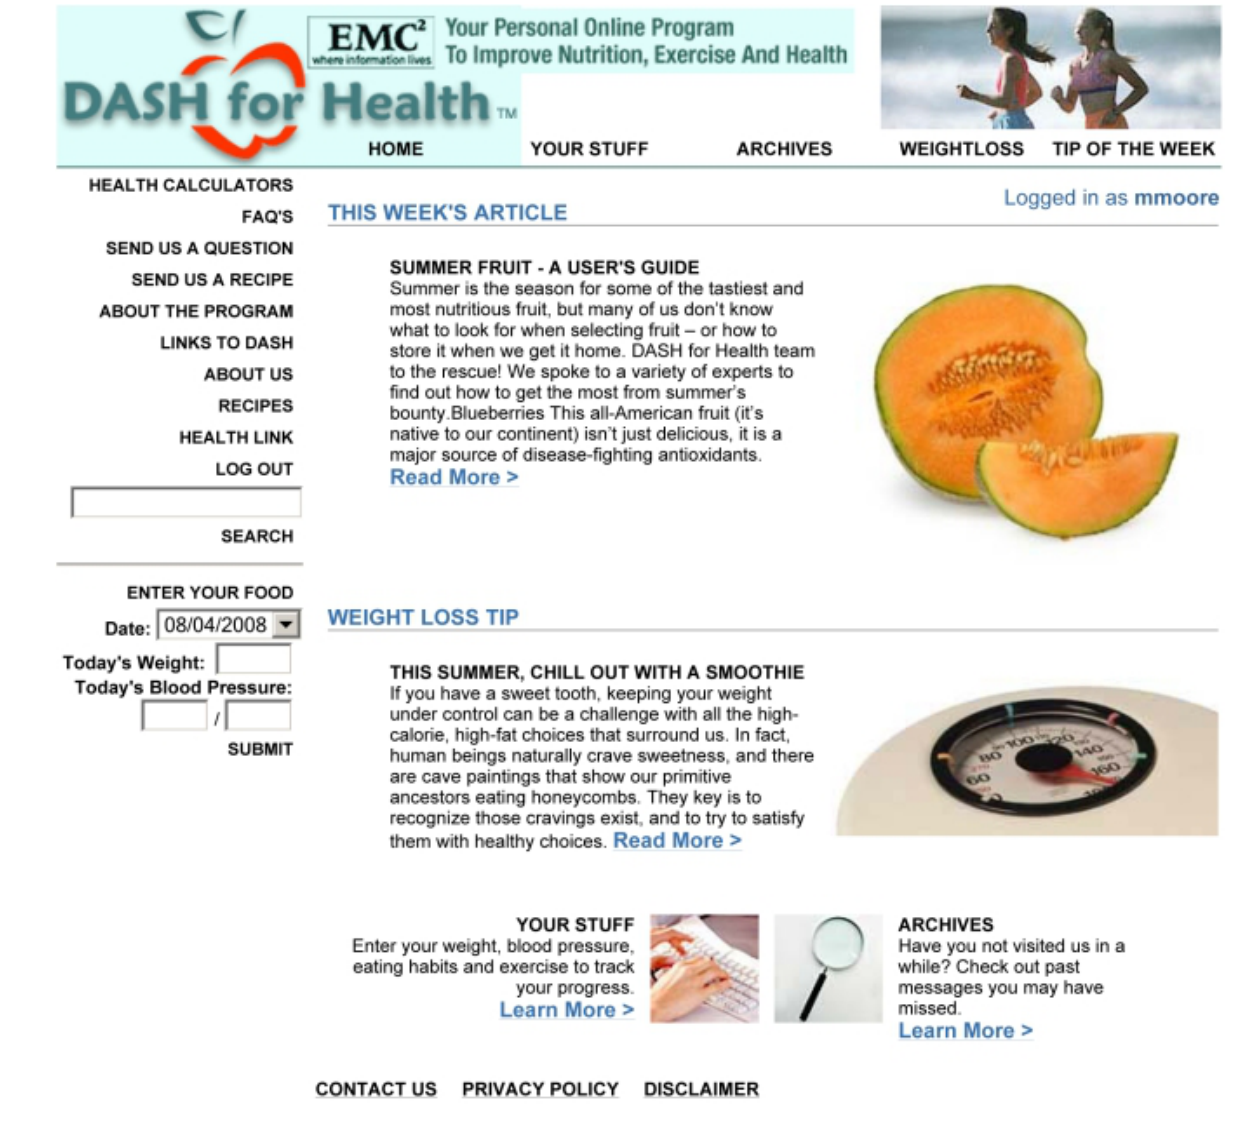
Figure 1. A view of the program’s homepage as designed for EMC Corporation